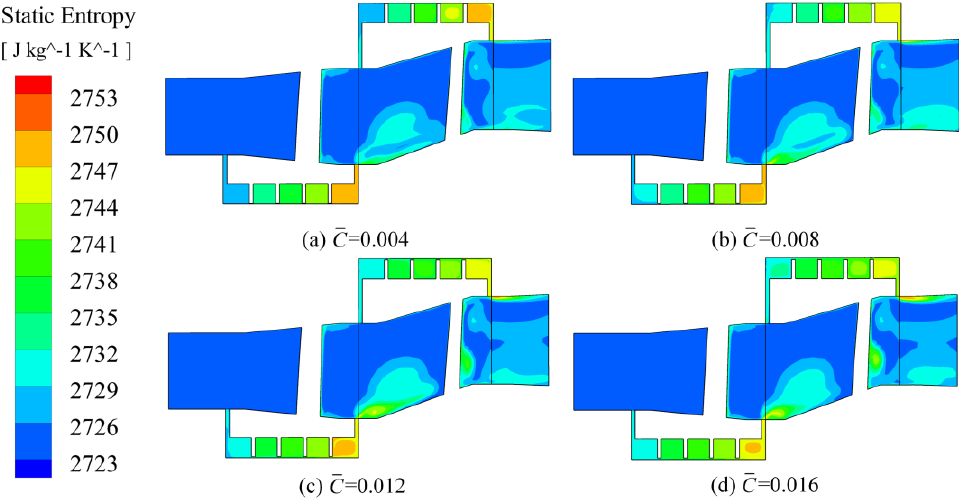
Figure 6. The static entropy contours of the meridional planes.